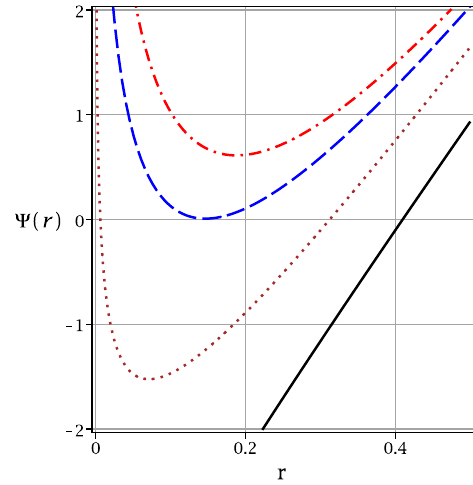
Fig. 1 (cid:10)( r ) versus r for k = 1, m = 5, (cid:16) = − 1, b = 1 . 2 and q = 1. α = 0 . 9, f (ε) = g (ε) = 0 . 9, β = 0 . 1 (continues line), β = 0 . 3 (dotted line), β = 0 . 534 (dashed line) and β = 0 . 7 (dashed-dotted